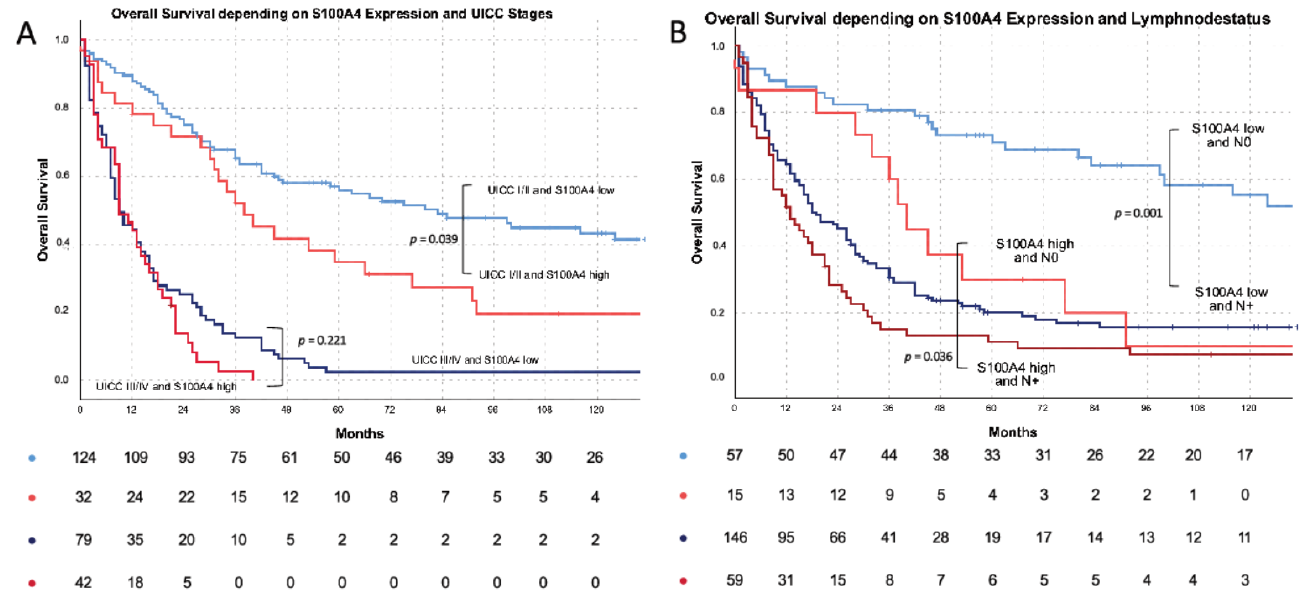
Figure 2. S100A4 survival and subgroup survival analysis: ( A ) S100A4 depending overall survival: n = 203 S100A4 low (blue): 66 months vs. n = 73 S100A4 high (red): 35 months mean survival ( p = 0.001). ( B ) S100A4 depending disease specific survival: n = 200 S100A4 low (blue): 83.6 months vs. n = 69 S100A4 high (red) 38.4 months mean survival ( p < 0.001). Tables below the Kaplan – Meyer curves describe the numbers of patients at risk.